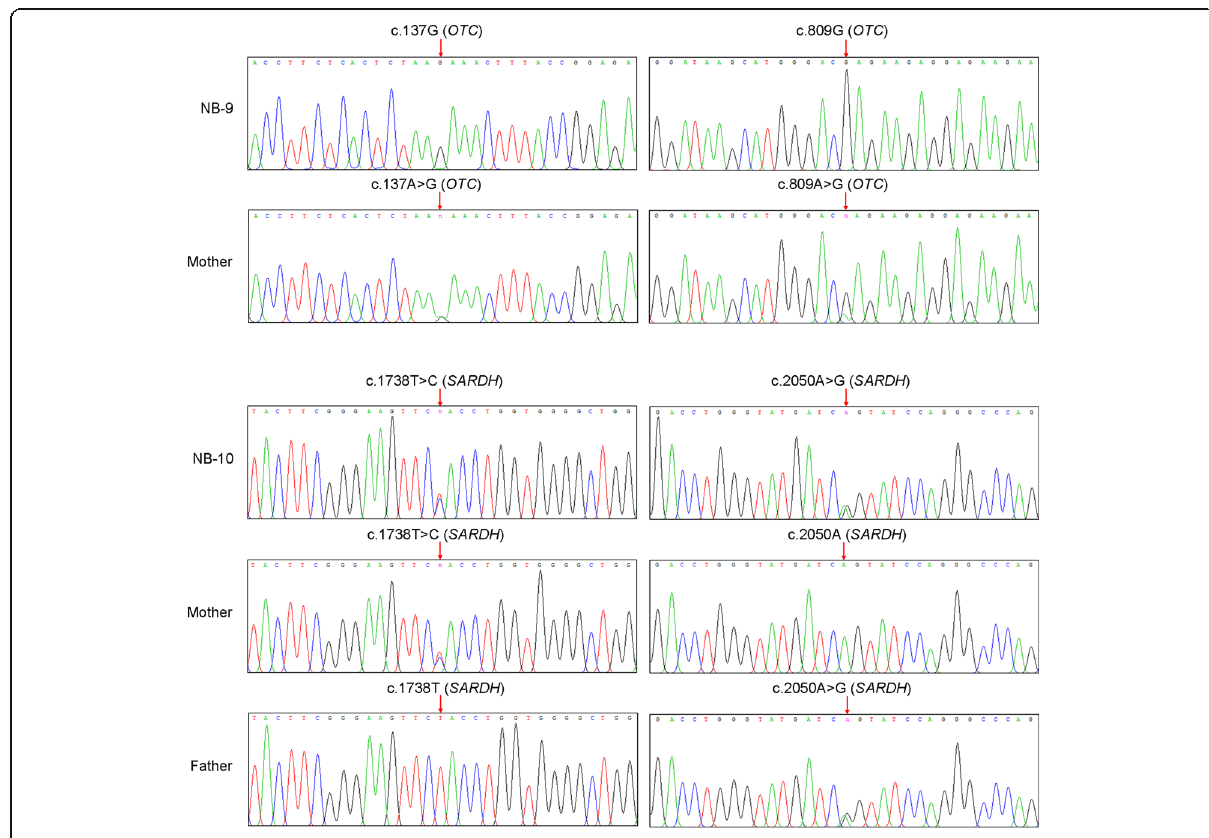
Fig. 3 Confirmation of IEM DNA variants detected in newborns 9 and 10 with false positive MS MS